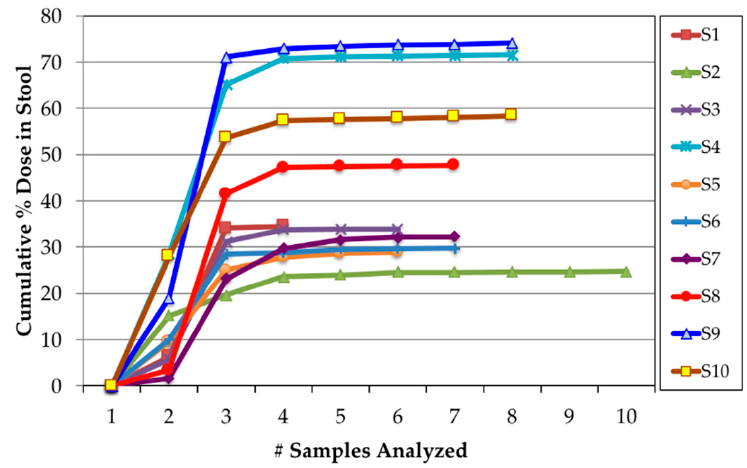
Figure 5. Time course of % dose recovered in stool after ingestion of in vivo labeled egg.